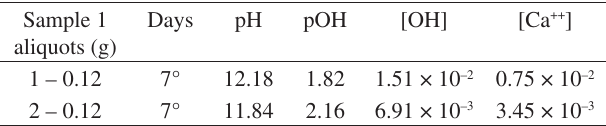
Table 3. pH of aliquots 1 and 2 of sample 1 after seven